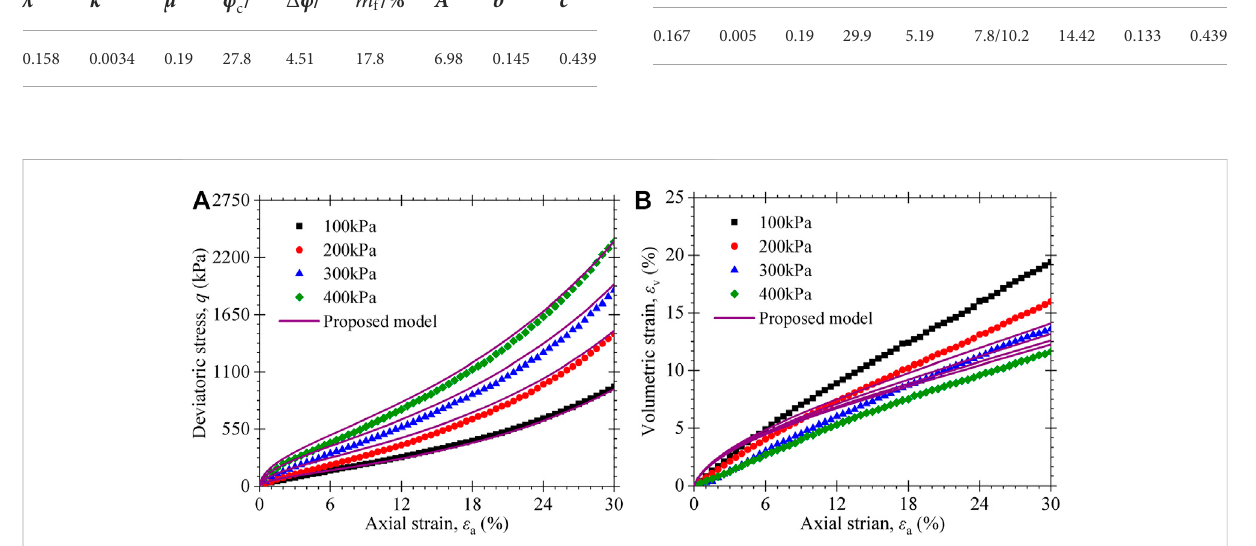
Experimental and predicted triaxial compression test results of MSW specimens in this paper: (A) stress – strain curves; (B) volumetric strain vs. axial strain curves.